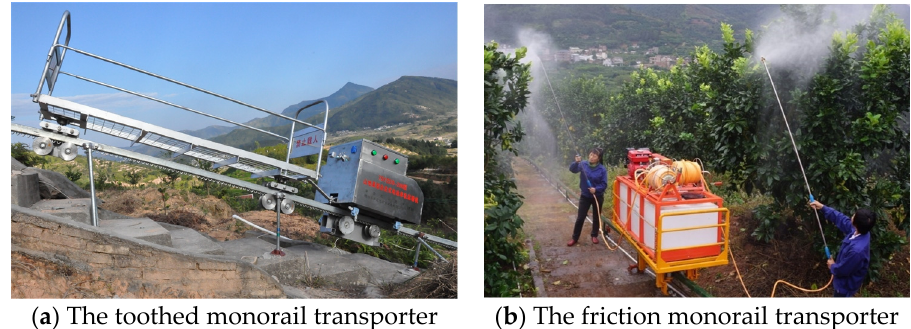
Figure 1. Two types of mountainous monorail transporters.